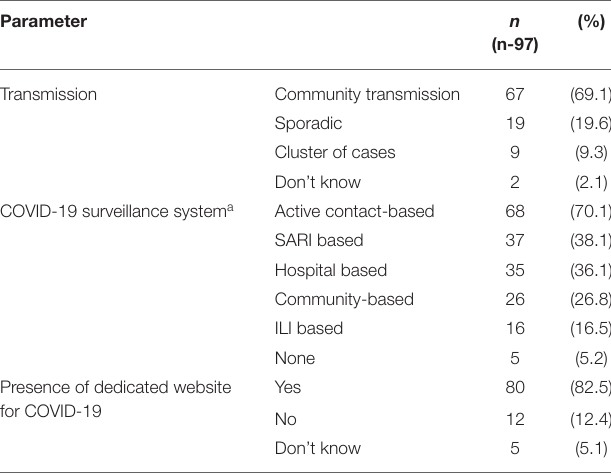
TABLE 2 | Perception of participants about COVID-19 transmission and surveillance mechanism in their country. Parameter